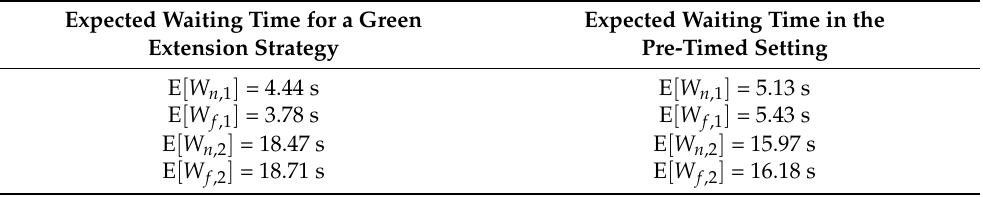
Table 2. Expected waiting time of a tagged